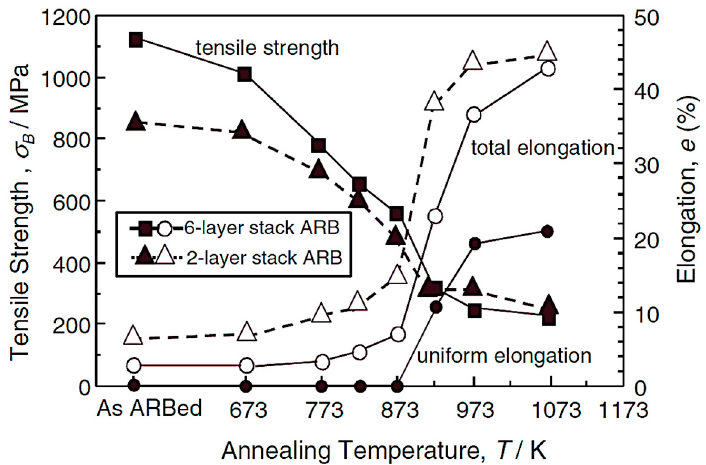
Figure 7. Changes in mechanical properties with annealing temperature of IF steel processed by three cycles of six-layer stack ARB compared to the results of a two-layer one [52].